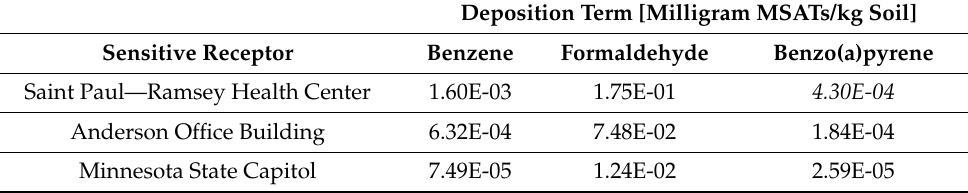
Table 9. Deposition Term Calculated Values at the Three Receptor